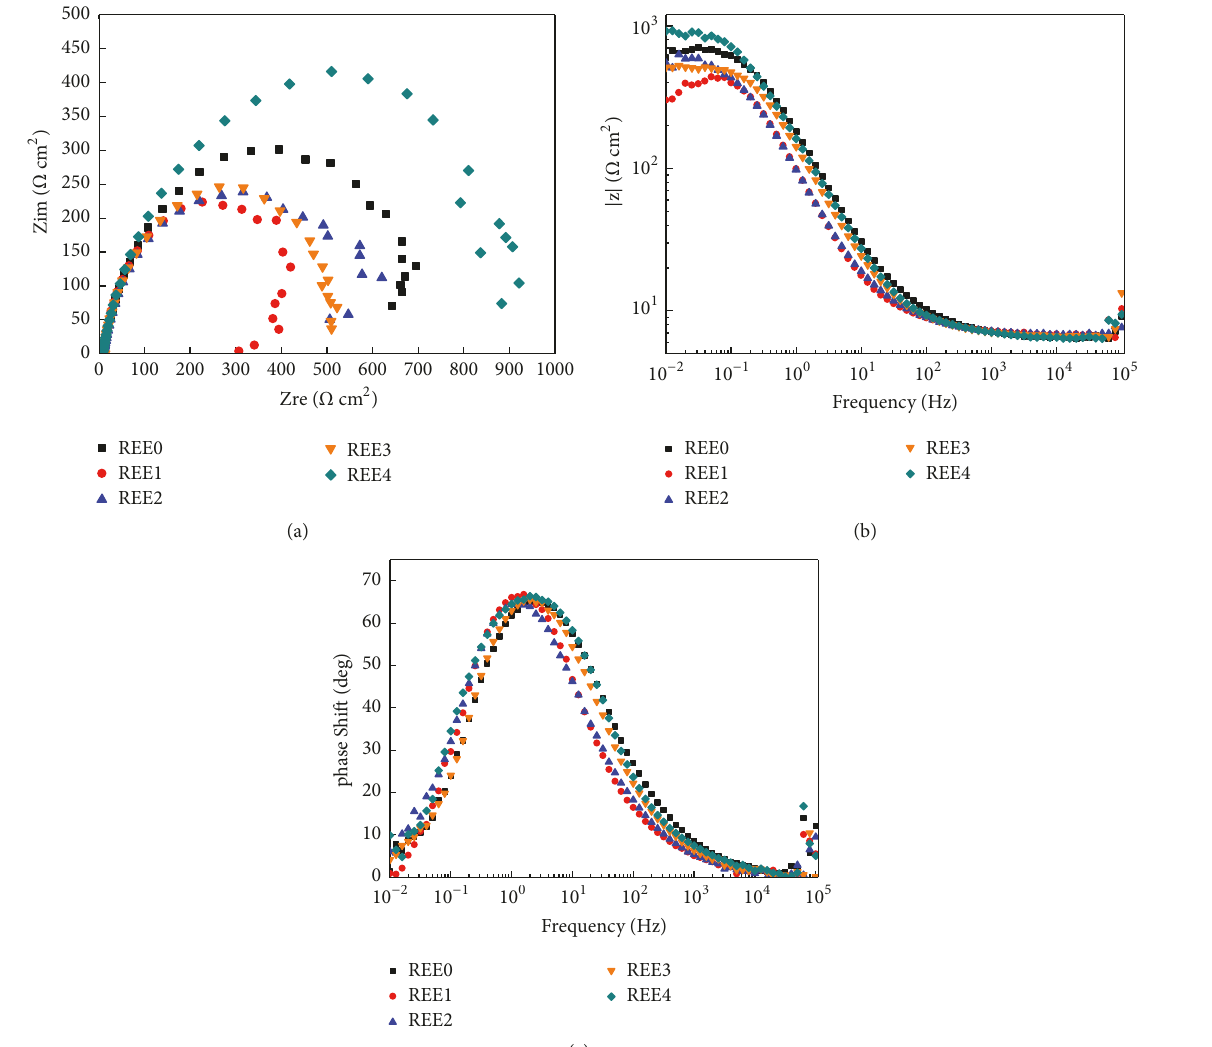
Figure 8: (a) Nyquist, (b) Bode, and (c) Bode-phase plots for the FCAW-welded metals with different REE contents versus OCP in a 3.5wt% NaCl solution.